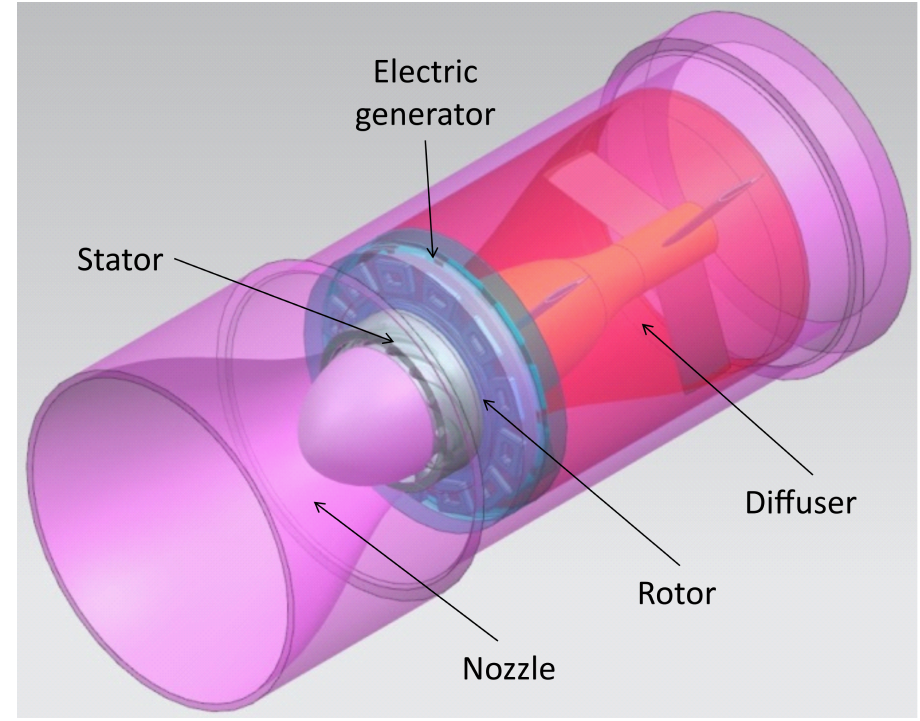
Figure 10. 3D model of the turbine under investigation.